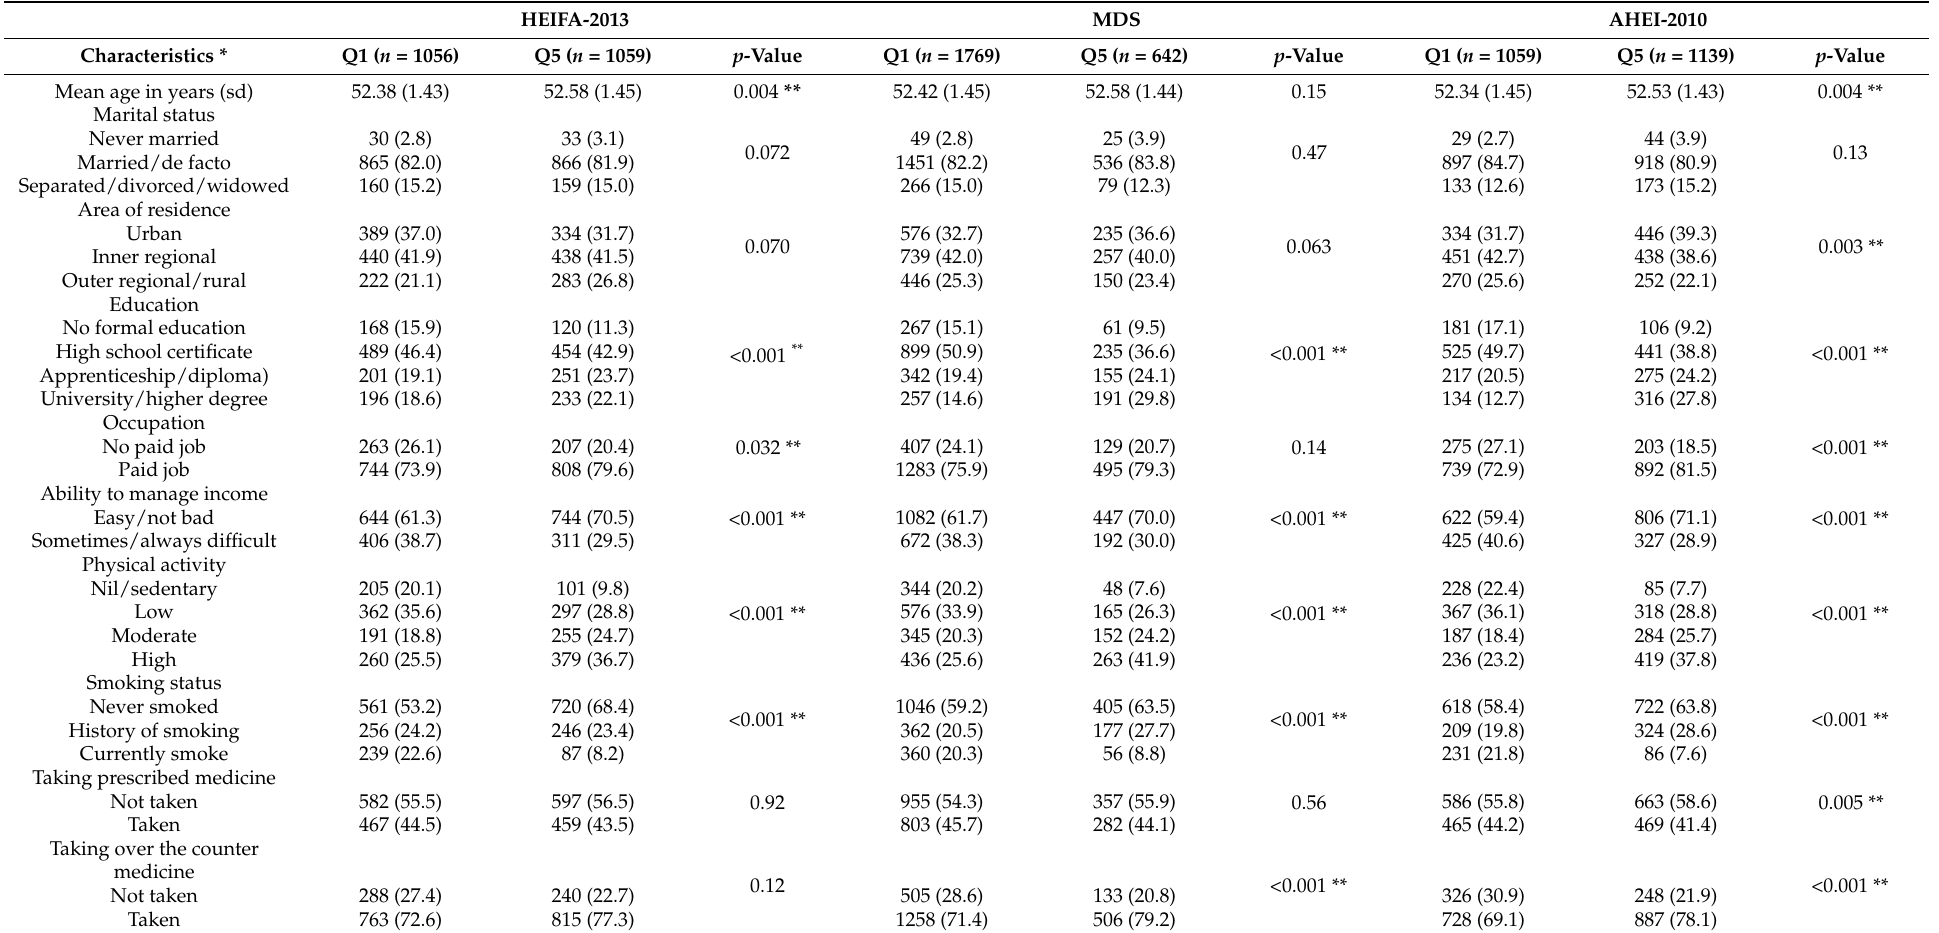
Table 1. Sociodemographic and lifestyle characteristics at study baseline (Survey 3 in 2001) related to the first (Q1) and fifth (Q5) quintiles of diet quality indices of the sampled women ( n =